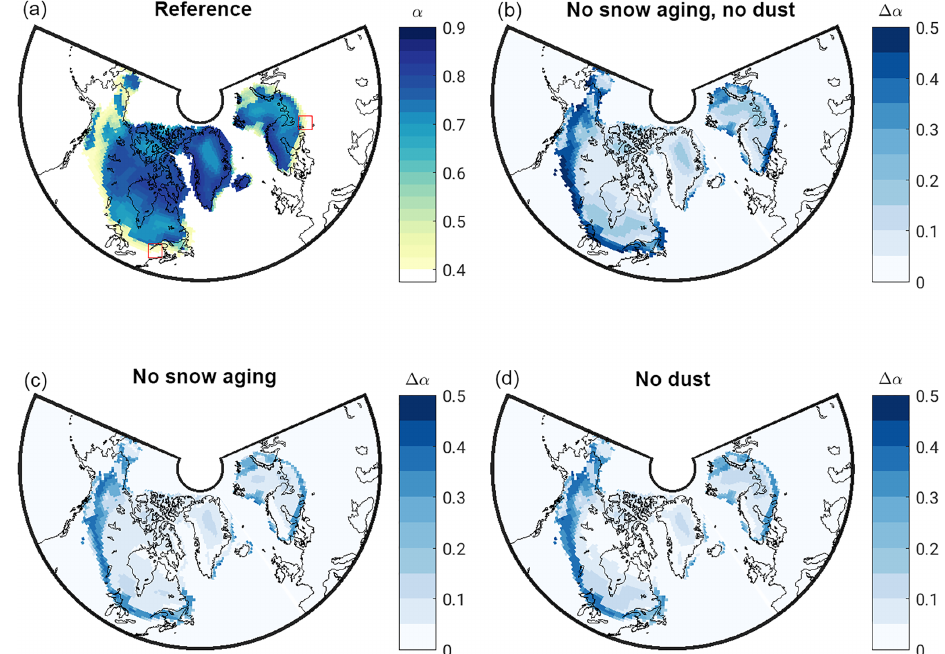
Figure 5. (a) Summer (June–July–August) ice sheets surface albedo at 15ka for the reference simulation. (b–d) Surface albedo anomalies relative to the reference for the three different offline simulations specified in the